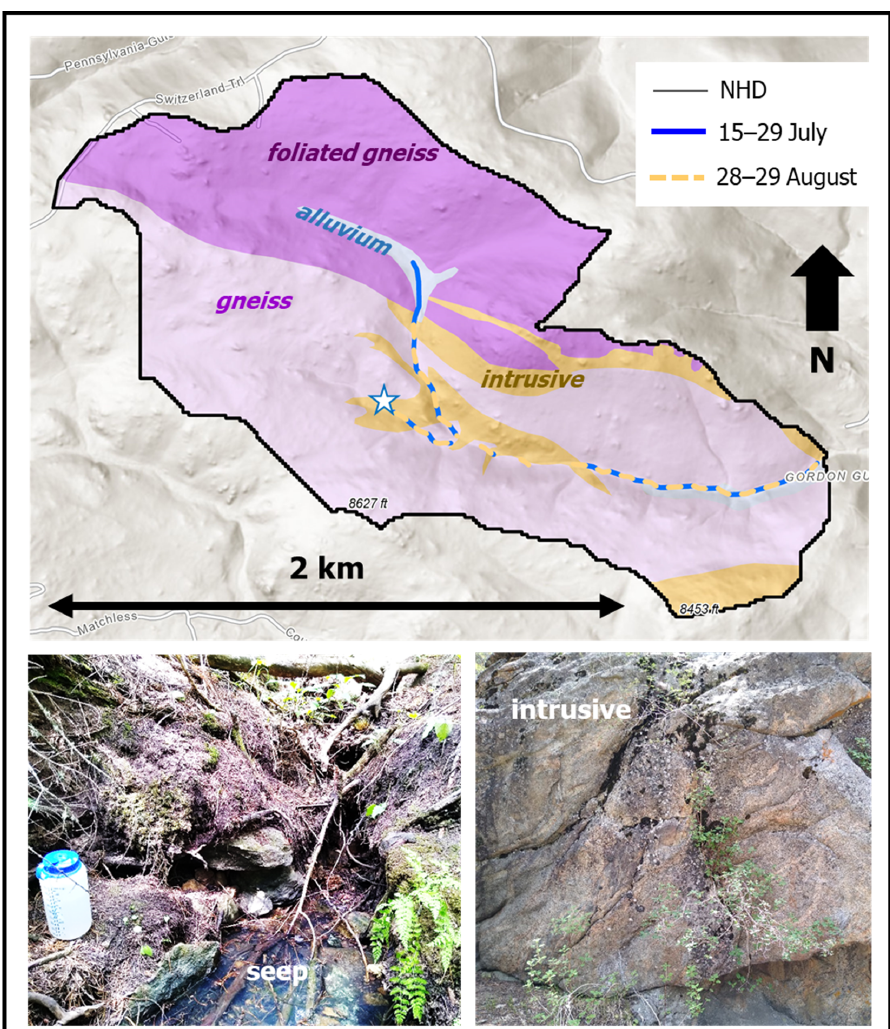
Figure 4. Gordon Gulch NHD HR flowlines and field-mapped streamflow locations over a hillshade and a digitized geologic map adapted from [61]. Blue lines indicate the surface flow locations for the first field survey, and dashed orange lines overlaying the blue lines indicate the surface flow locations for the second survey. The lower-left image is from the southern flow head (star), where the flow emerged below a step change in the channel bed elevation. The lower-right image is an example of an intrusive bedrock outcrop with seepage along the bedrock fractures, where vegetation was present.